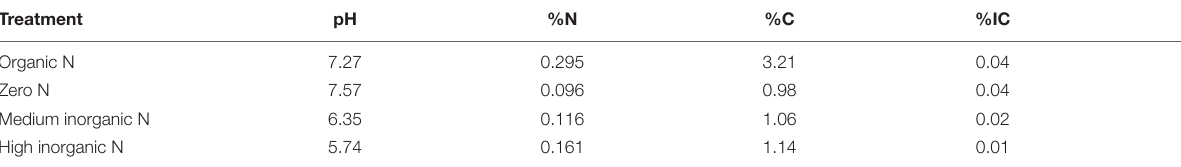
TABLE 2 | Values obtained from soil chemical analyses.